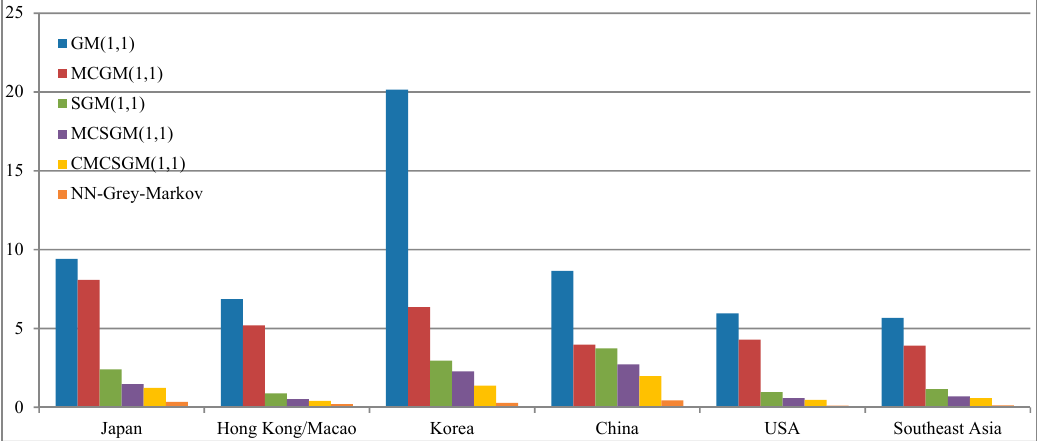
Figure 2. Testing results for Case I. 4.3.2. Case II Historical annual data from 1997 to 2013 published by China National Tourism Administration were used to conduct the second experiment. The data were summarized in Reference [25]. The collected data were associated with foreign tourists from eight main countries, including Japan, Korea, Malaysia, Mongolia, Philippines, Russia, Singapore, and USA. Year 2013 was used for testing by a one-step transition probability matrix. Performing the rolling mechanism, 2005–2012 data from Korea, Japan, USA, and Malaysia; 2006–2012 from Russia, 2003–2012 from Mongolia and Philippines; and 2004–2012 from Singapore from 2004 to 2012 can be used to construct the SGM(1,1), the MCSGM(1,1), the CMCSGM(1,1), and proposed NN-Grey-Markov models. The original GM(1,1) and the MCGM(1,1) were constructed using data from 1997 to 2012 for each economy. Using the same data, Sun et al. [25] demonstrated the effectiveness of the CMCSGM(1,1) model. Figures 3 and 4 show prediction results with respect to model fitting and testing for different prediction models, respectively. For model-fitting, Figure 3 shows that the proposed NN-Grey-Markov model is comparable or superior to the compared models. It is slightly inferior to the CMCSGM(1,1) model for Malaysia. As for testing results, prediction accuracy of the proposed NN-Grey-Markov model outperforms that of the CMCSGM(1,1) model, except for Malaysia and Singapore. The proposed grey prediction model is superior to the original GM(1,1), the SGM(1,1),